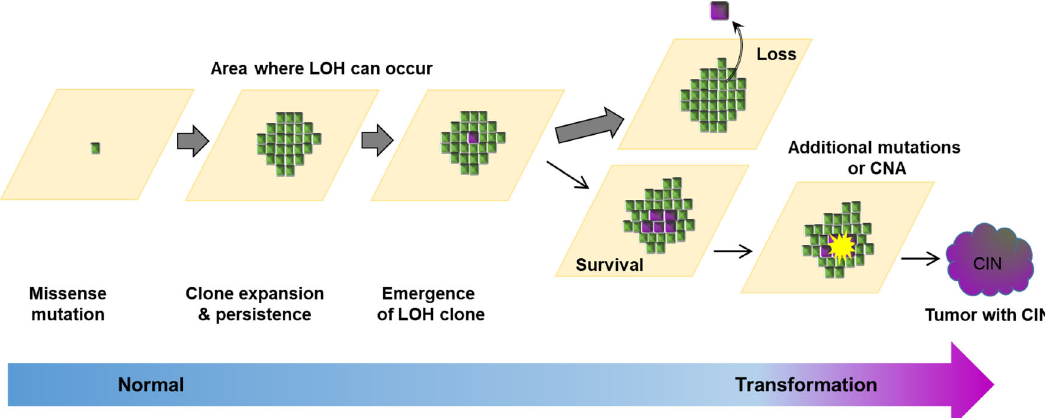
Fig. 7 | Mutant p53 in normal epithelia in carcinogenesis. Heterozygous p53 mutation in single cells in normal epithelia confers a proliferative advantage, clonal expansion, and a population of mutant cells that persists to